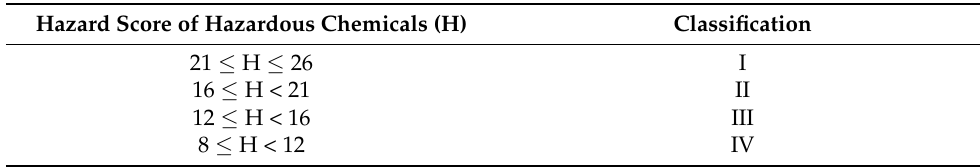
Table 3. Classification of hazardous